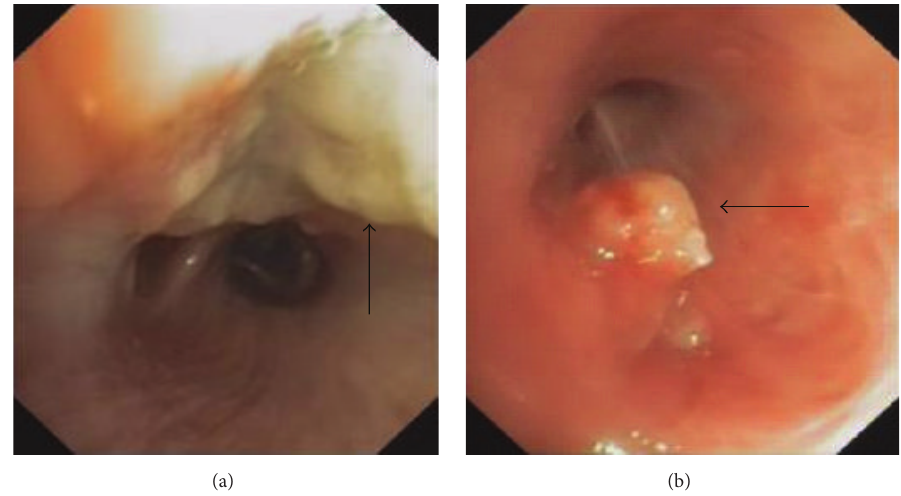
Figure 2: Bronchoscopic images: the arrows are pointing to different views of nocardial white friable lesions (a) and mass (b) in the right lower lobe.